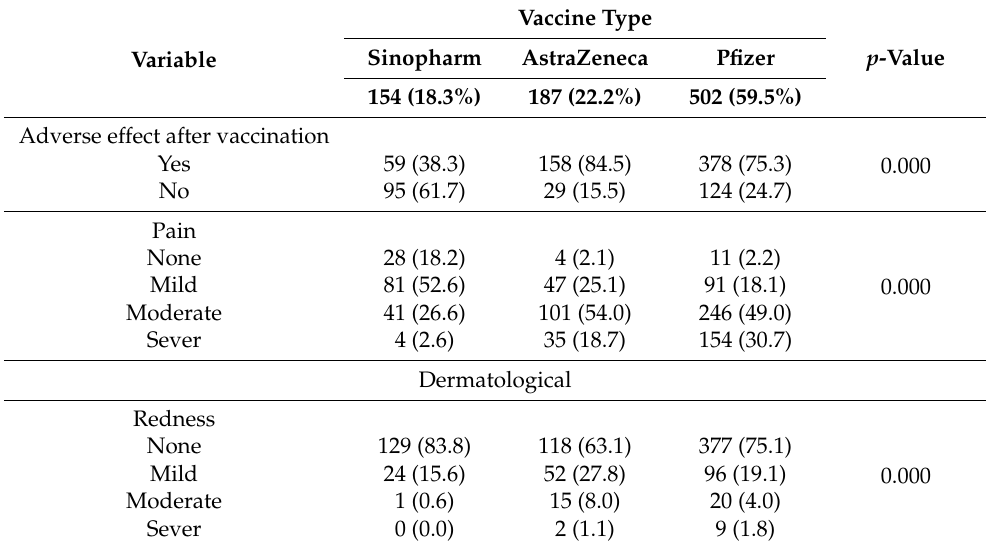
Table 2. Adverse effect distribution among the study